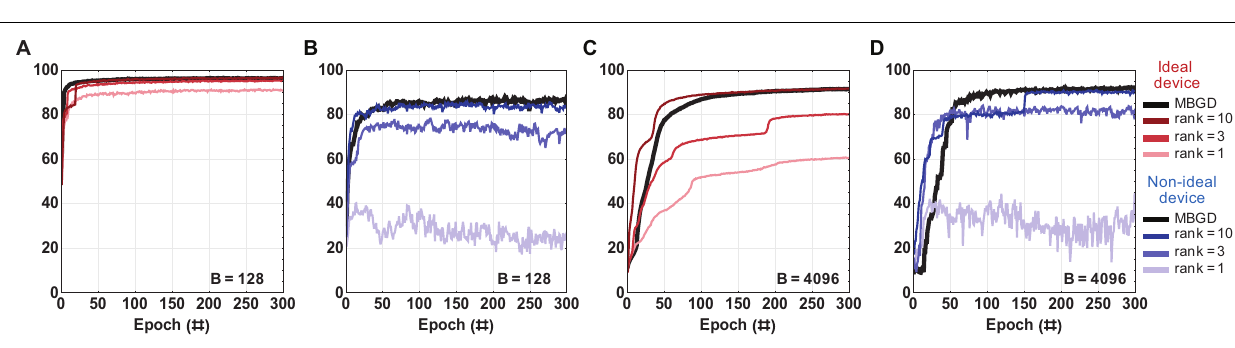
FIGURE 8 | The rank-sum Non-Negative Matrix Factorization (NMF) results for a multi-layer perceptron with ideal vs. non-ideal memristive weights at different ranks and batch sizes. (A,B) Convergence curves using the rank-sum weight transfer method at batch size = 128; and similarly (C,D) at batch size = 4096. The results show that the NMF can approximate fairly well the MBGD results, particularly for ranks 3 and 10. For all these experiments, the rounding method is